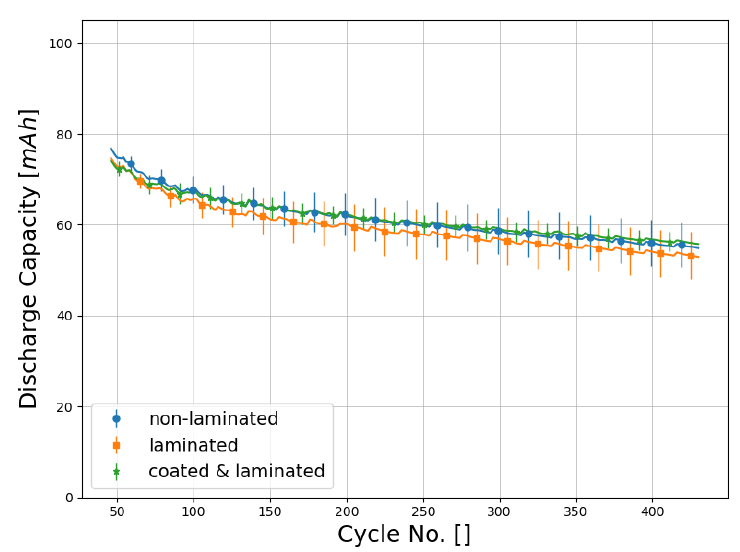
Figure 10. Results of 1 C cycling test on cells with coated PE separator. Laminated at mild conditions of 60 °C and 5 N/mm. The discharge capacity in the sixth cycle is an measurement artifact due to an internal resistance measurement.